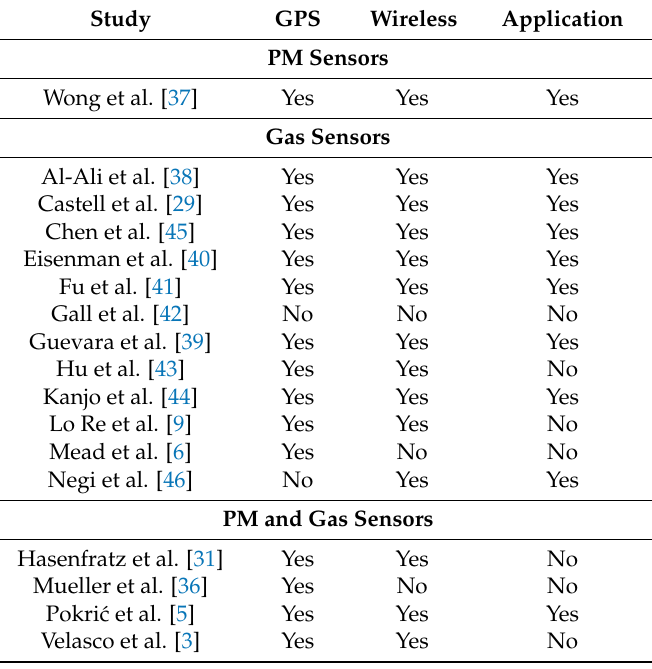
Table 4. Presence or absence of GPS, wireless and web/smartphone application technologies in reported studies. Study GPS Wireless Application PM Sensors Wong et al.